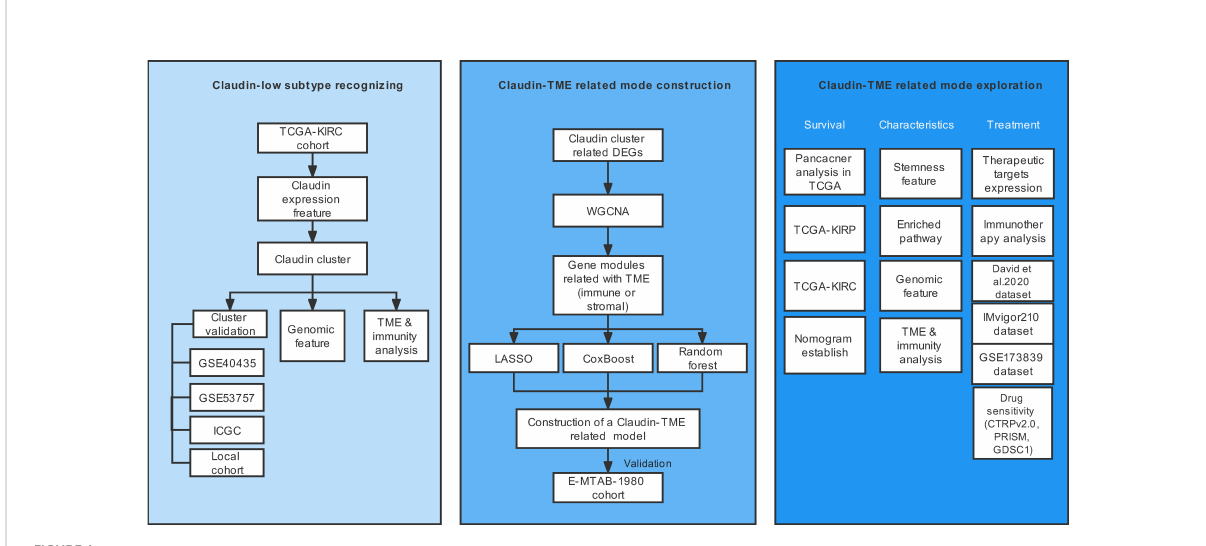
FIGURE 1 Overview of the study design. TME: tumor